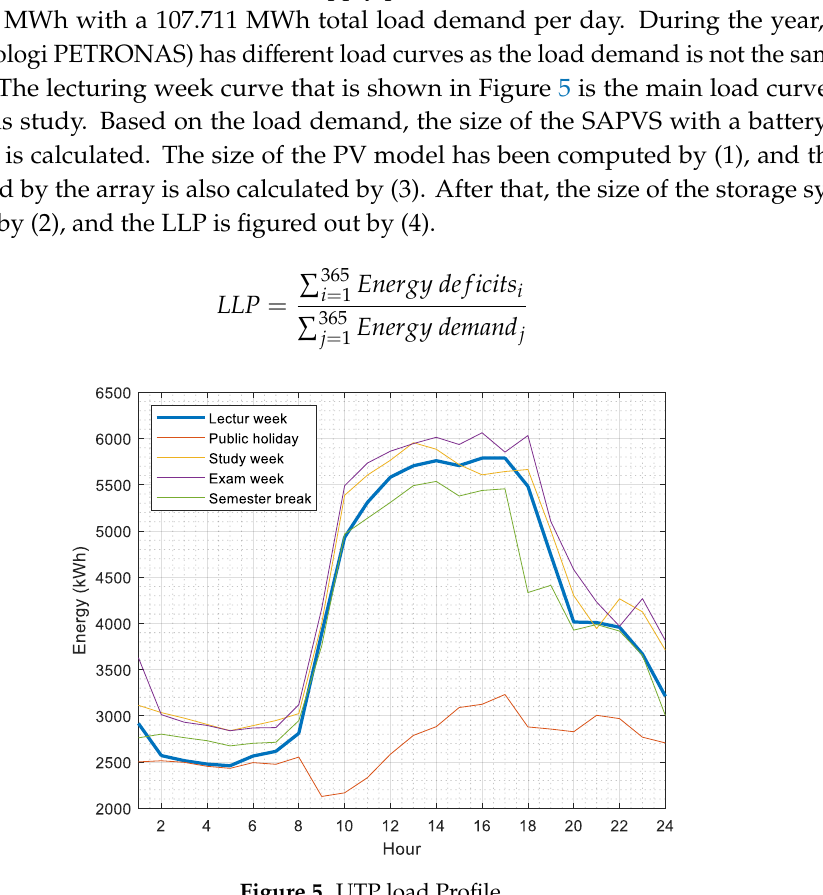
Figure 5. UTP load Figure 5. UTP load Profile .